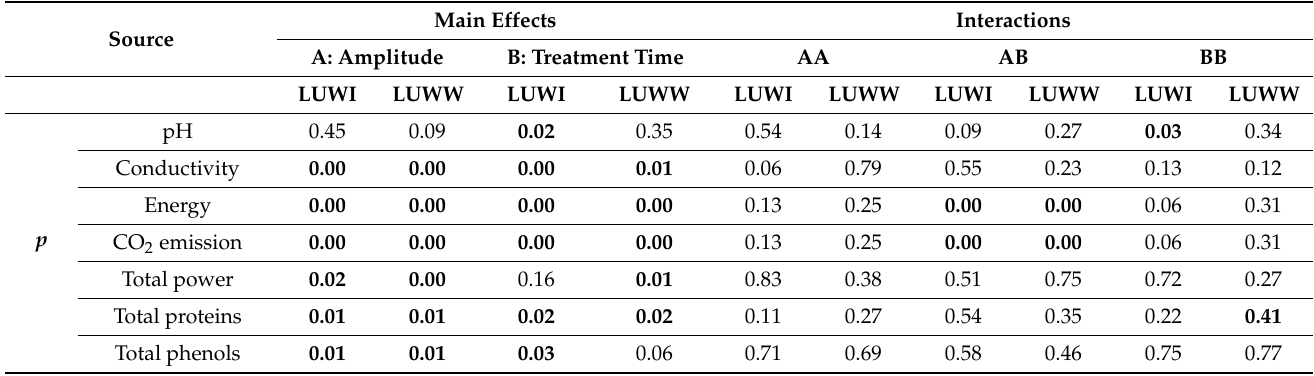
Table 6. Statistical significance for pH, conductivity, energy, CO 2 emission, power, total proteins, and total phenols. MANOVA statistically processes the variability of each input parameter, their mutual interactions, and quadratic interactions on the output values of LUWI and LUWW samples.